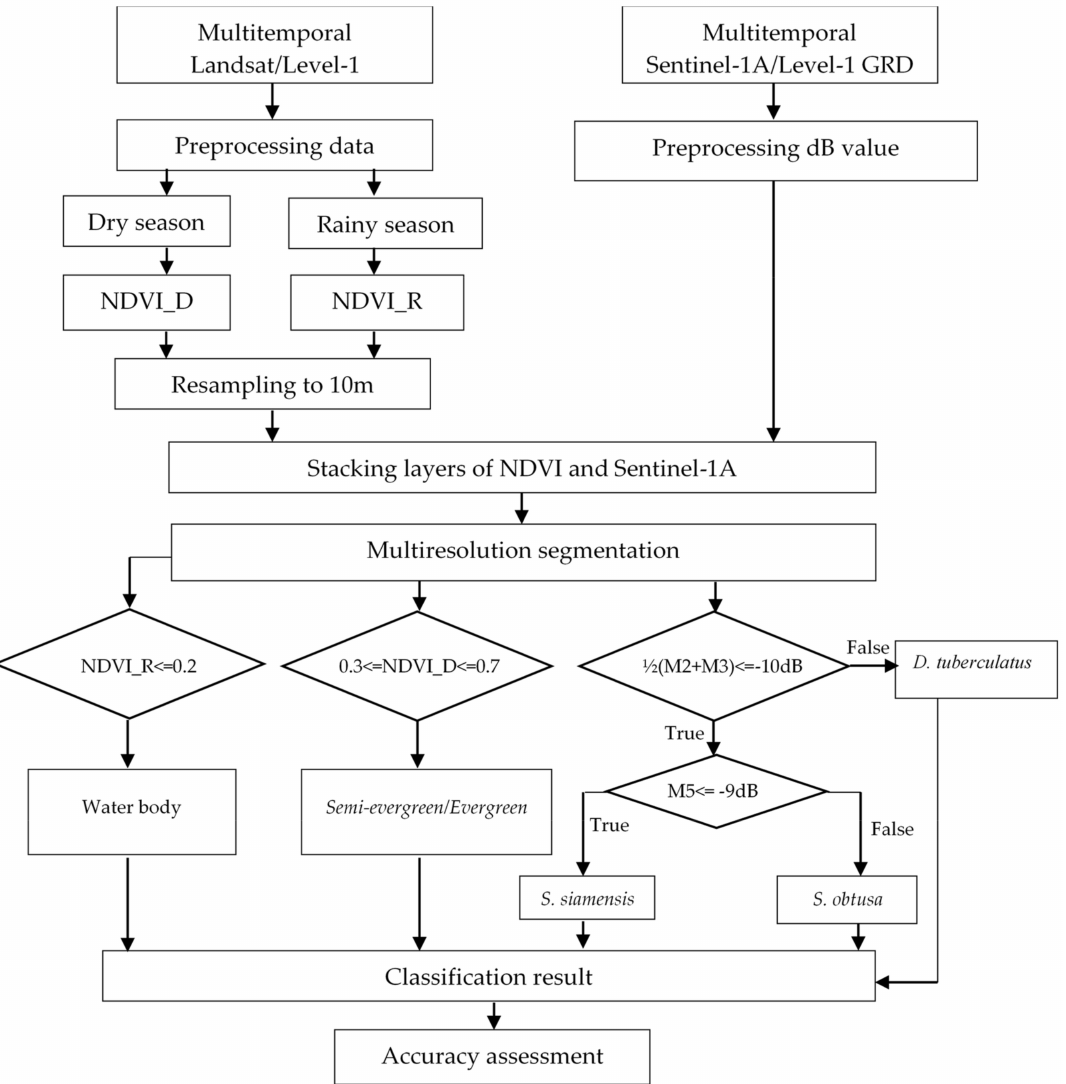
Figure 7. Identification scheme of deciduous forest species by using Sentinel-1A and Landsat 8 images. NDVI_D is the NDVI in the dry season and NDVI_R is NDVI in the rainy season. In this flowchart, M2 is the mean backscatter value in February, M3 in March, and M5 in